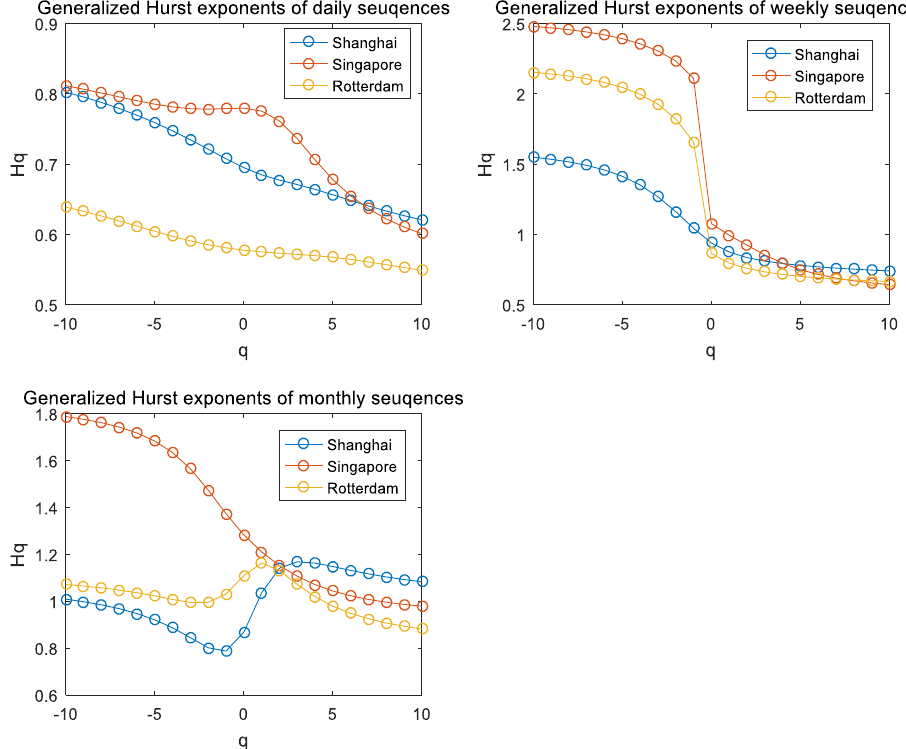
Figure 6. Hurst exponents of ship flow sequences calculated by Multifractal Detrended Fluctuation Analysis (MF-DFA) for q = [ − 10 : 10 ]